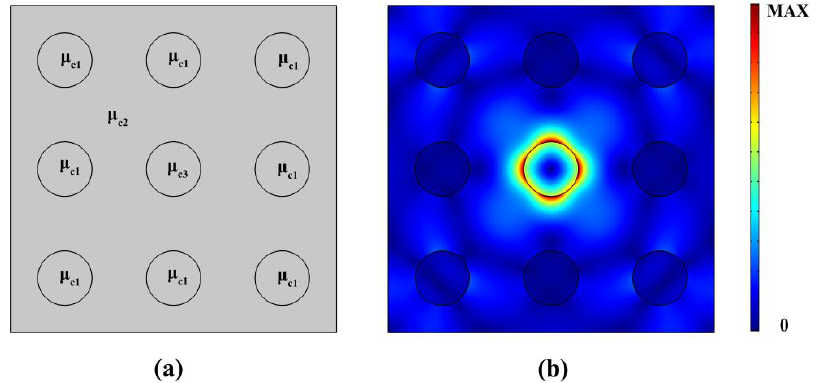
Figure 8. ( a ) Schematic of PhC nanocavity with ultra-small size of 60 × 60 nm, μ c1 = 0.6 eV, μ c2 = 0.9 eV; ( b ) The normalized electric field distribution of the resonant modes of the defect, with μ c3 from 0.085 eV to 0.25 eV.